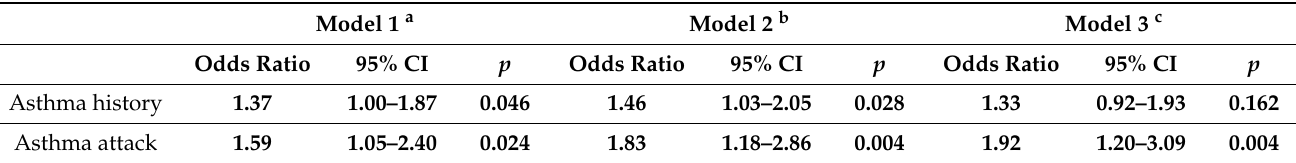
Figure 1. Effect sizes of the associations between parent report of asthma, asthma attack, suicidal ideation, and suicide attempt. Caption: bars represent the odds ratio and 95% confidence intervals of models co-varying for demographics, household-level socioeconomic factors, and neighborhood- level factors. The odds ratio increases for more severe presentations of asthma (attack vs. history) and for more severe presentations of suicidality (SA vs. SI). Abbreviations: SI = suicidal ideation; SA = suicide attempt. Table 4. Association between asthma and suicide